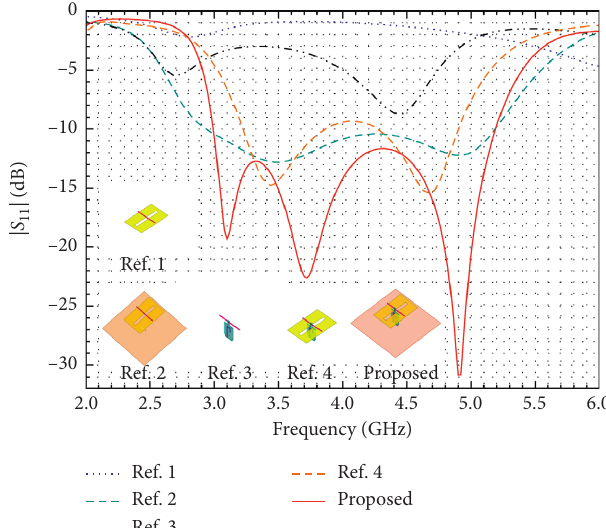
Figure 3: Evolution of the proposed antenna.